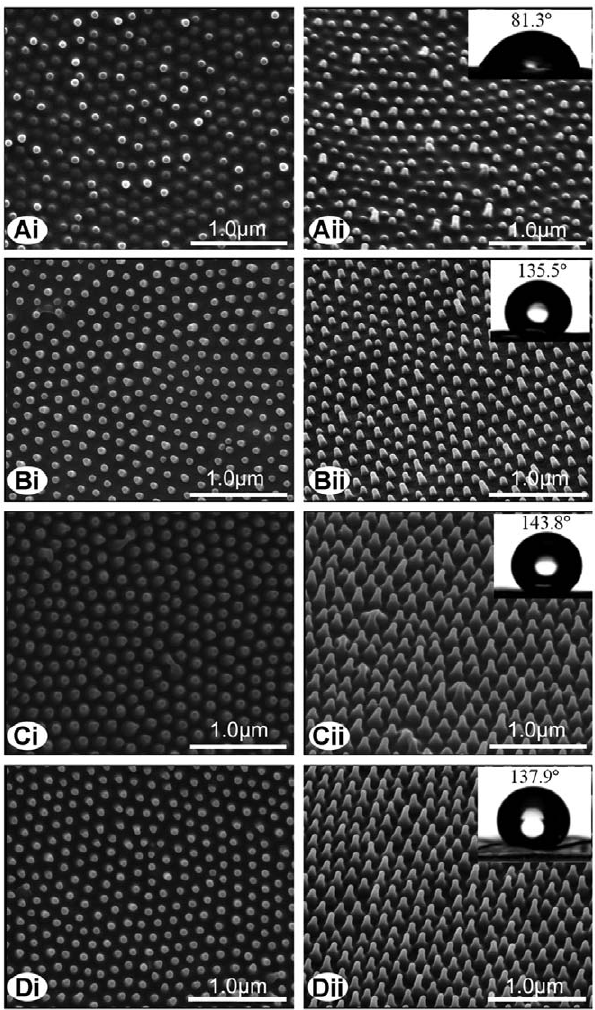
Figure 1. SEM images of four species of cicada wing surfaces. (A) Leptopsalta bifuscata ; (B) Aola bindusara ; (C) Meimuna opalifer ; (D) Cryptotympana atrata . The insets are the optical images of water droplets on the wing surfaces. Subsections (i) show a top view and (ii) show a 30 u inclined view of the wing membranes.